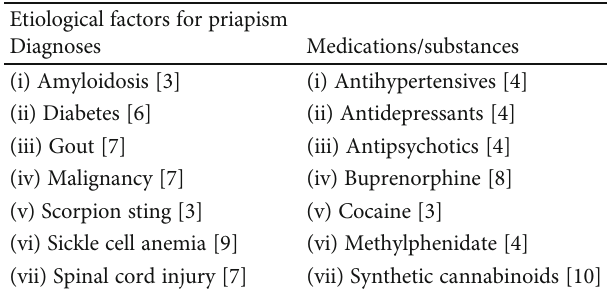
Table 1: Di ff erential diagnoses, medications, and substances that have been associated with